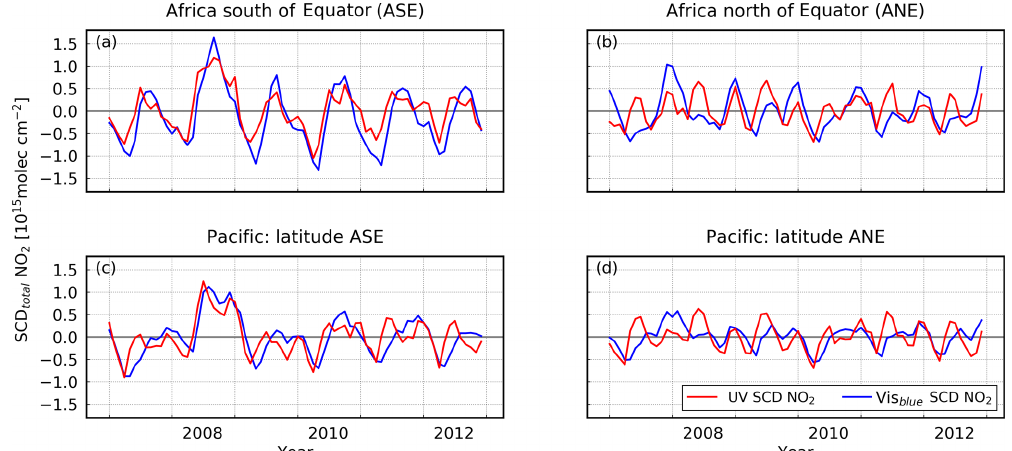
Figure A3. Time series of detrended total NO 2 SCDs for the UV and blue spectral range for ASE (a) and ANE (b) as well as detrended time series over the Pacific reference sector area for the latitude of ASE (c) and ANE (d) . The vertical lines indicate January of the individual years.